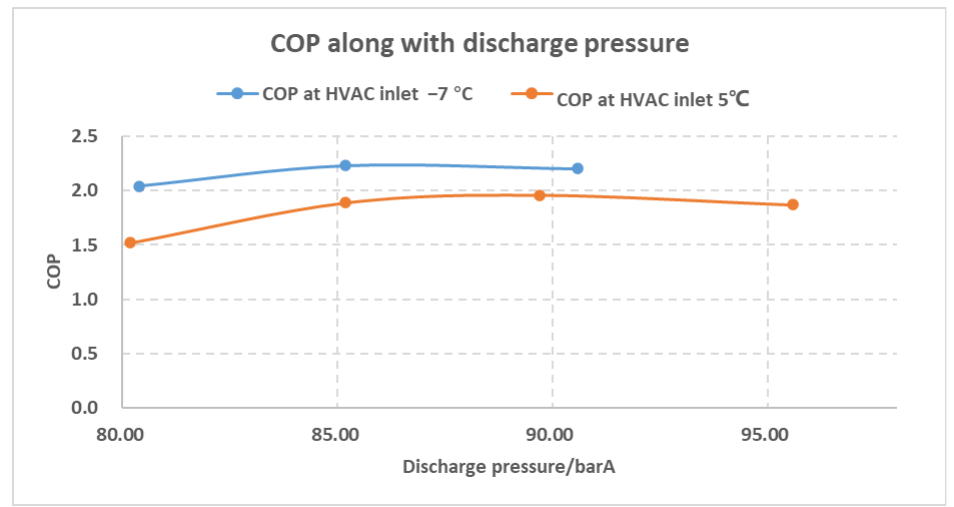
Figure 8. COP along with different discharge pressures at − 7 °C and 5 °C.